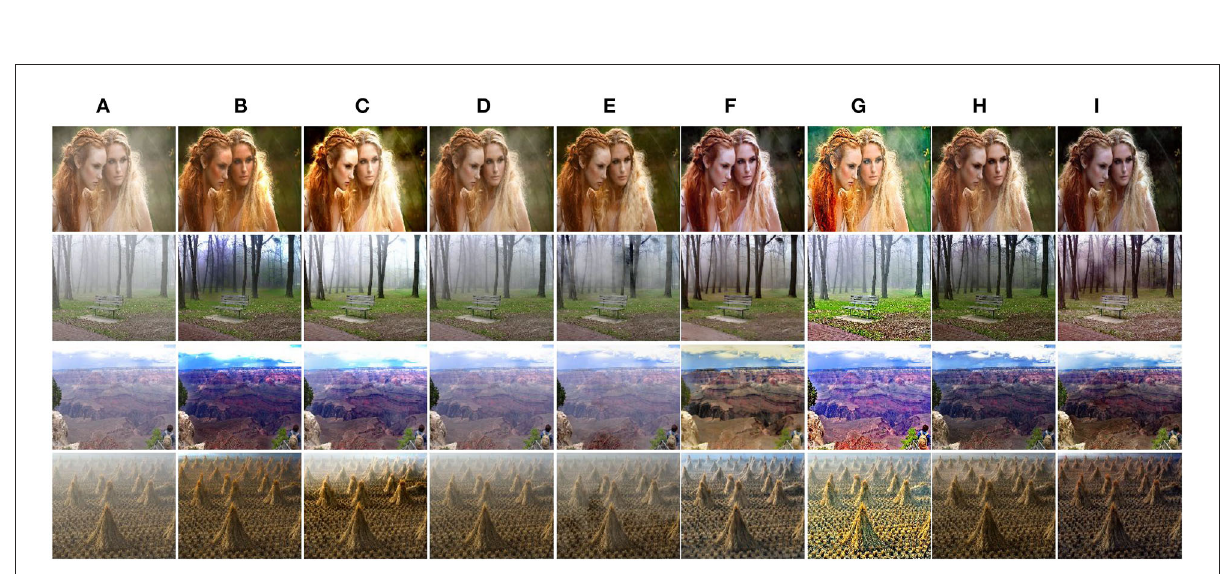
FIGURE7 Qualitative comparisons on real-world images from Fattal (2014). (A) Hazy. (B) DCP. (C) DCPDN. (D) MSBDN. (E) FFA. (F) DA. (G) PSD. (H) RefineD. (I) Ours.